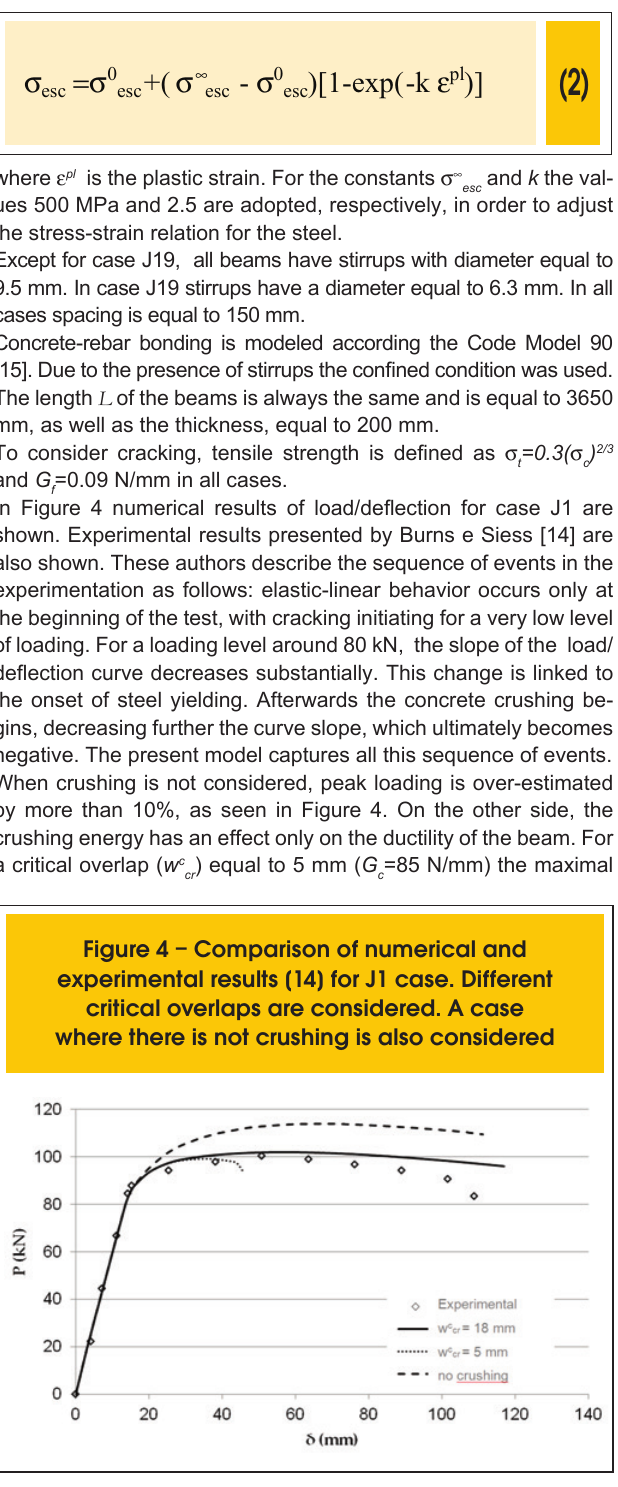
Figure 5 – Bending stresses, J1 case c